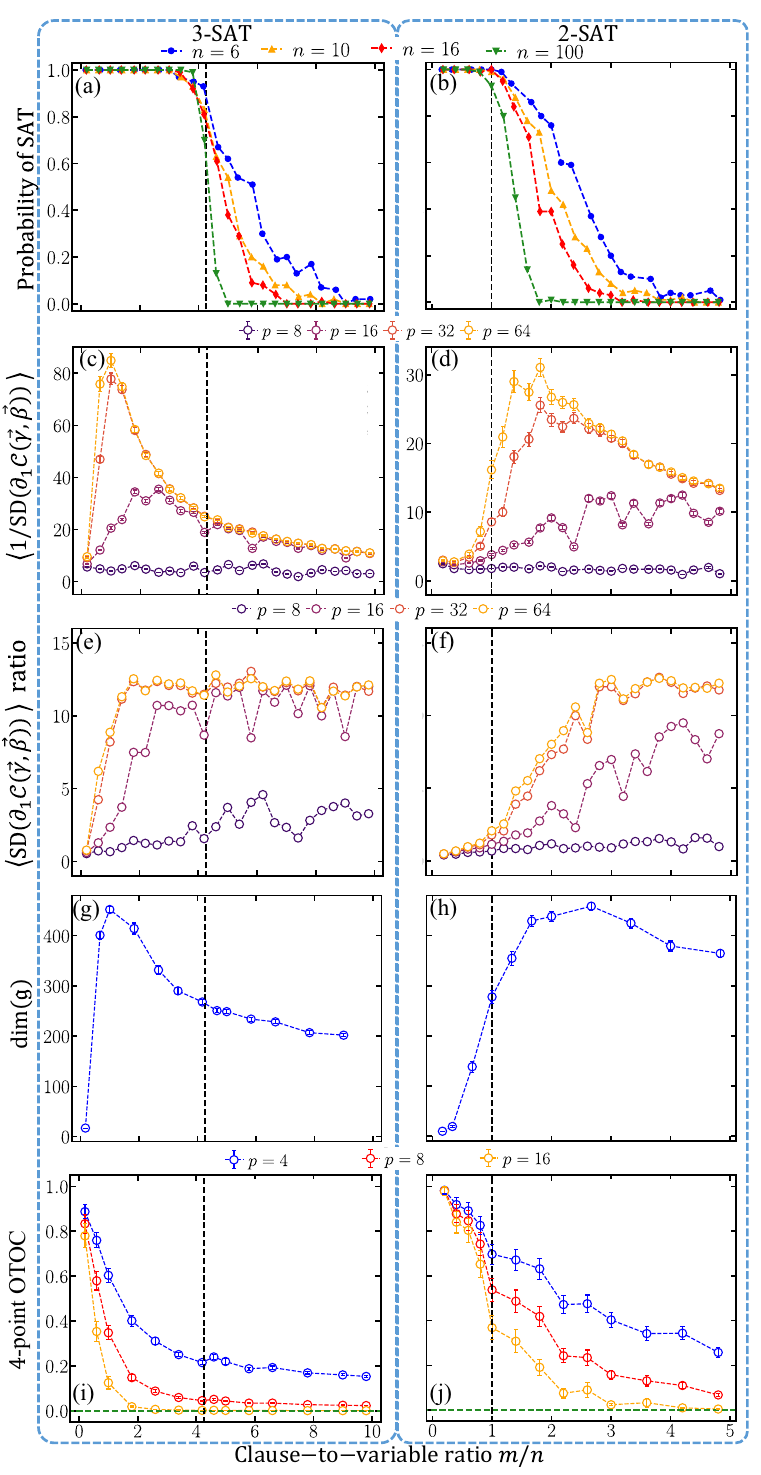
Fig. 1 SAT-UNSAT phase transition and trainability of 3-SAT (left column) and 2-SAT. a , b Probability of SAT for different system size n . ! c , d The mean of 1 = SD ð ∂ 1 Cð γ ! ; β ÞÞ in different p -layer QAOA with n = 16 variables. The inverse is added for easier comparison according to ! Eq. (4). e , f The ratio between the average gradient variance h SD ð ∂ 1 Cð γ ! ; β ÞÞi of n = 6 variables over that of n = 16 variables in different p -layer QAOA. Larger ratio indicates barren plateau. g , h The dimension of dynamical Lie algebra dim ð g Þ for generators in QAOA in an n = 6 qubits system (see Eq. 4). i , j Average of 4-point OTOC for different p -layer QAOA with n = 10 variables (see Eq. 5). Green horizontal dashed line represents the value given by Haar unitary − 2 n /(4 n − 1). Vertical dashed lines indicate the critical SAT-UNSAT transition point. All results and error bars are estimated over 100